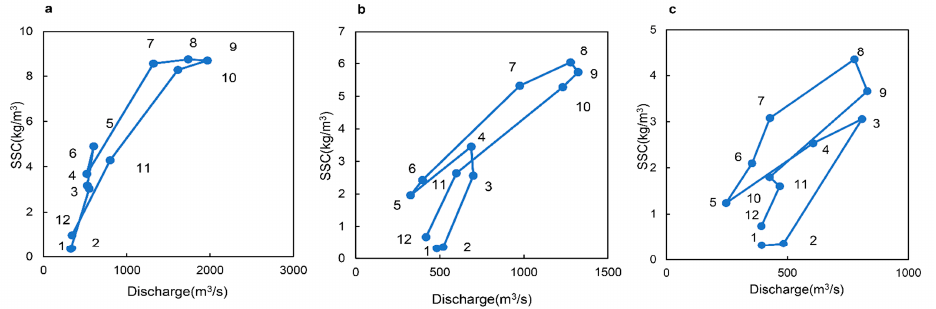
Figure 5. Monthly average hysteresis loop of SSC and discharge during the period of 1960 − 2015 at ( a ) Longmen, ( b ) Tonguan, ( c ) Huayuankou stations.